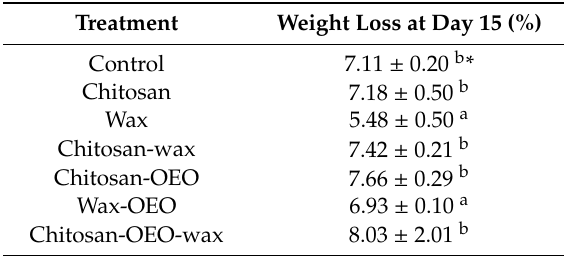
Table 3. Weight loss of cucumbers coated with chitosan, OEO, and carnauba wax and stored at 10 ◦ C for 15